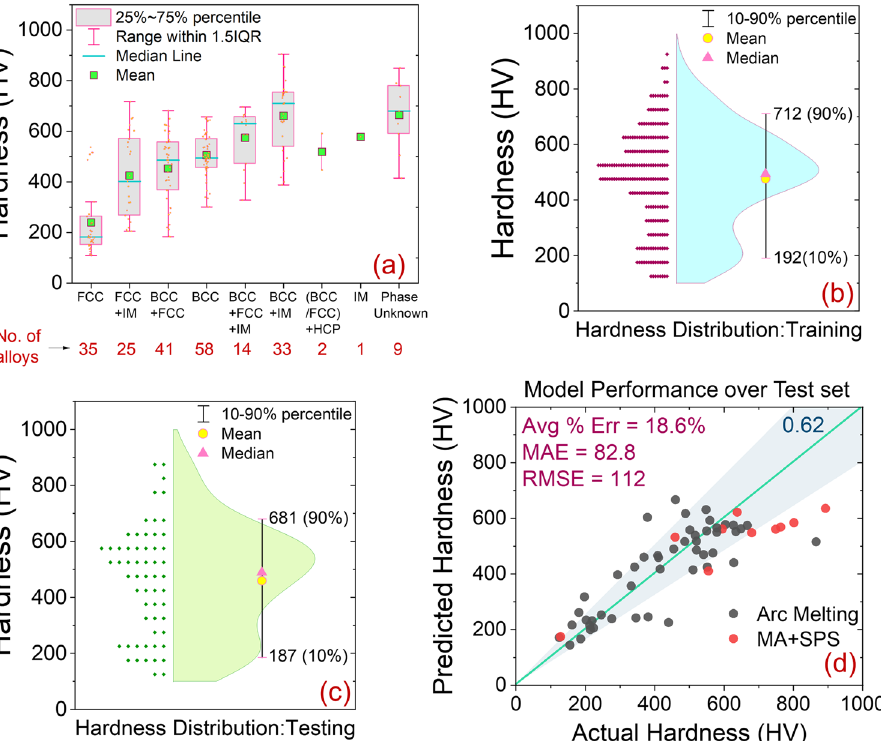
Fig. 2 Dataset exploration and model validation. a Statistical distribution of hardness values for eight different type of phase combinations present in the dataset along with number of alloys, mean hardness, median hardness, 1.5 IQR and 25 – 75% percentile range for each structure. b Distribution of hardness values in the training dataset (218 alloys) along with mean, median and 10 – 90% percentile range of hardness. c Distribution of hardness values in the test dataset (58 alloys) compiled from recent literature. d Parity plot of hardness predictions obtained for test dataset along with statistical performance metrics – root mean square error (RMSE), mean absolute error (MAE) and average percentage error. The shaded area represents an 80% accuracy region and the number at top right corner represents fraction of predictions with >80%